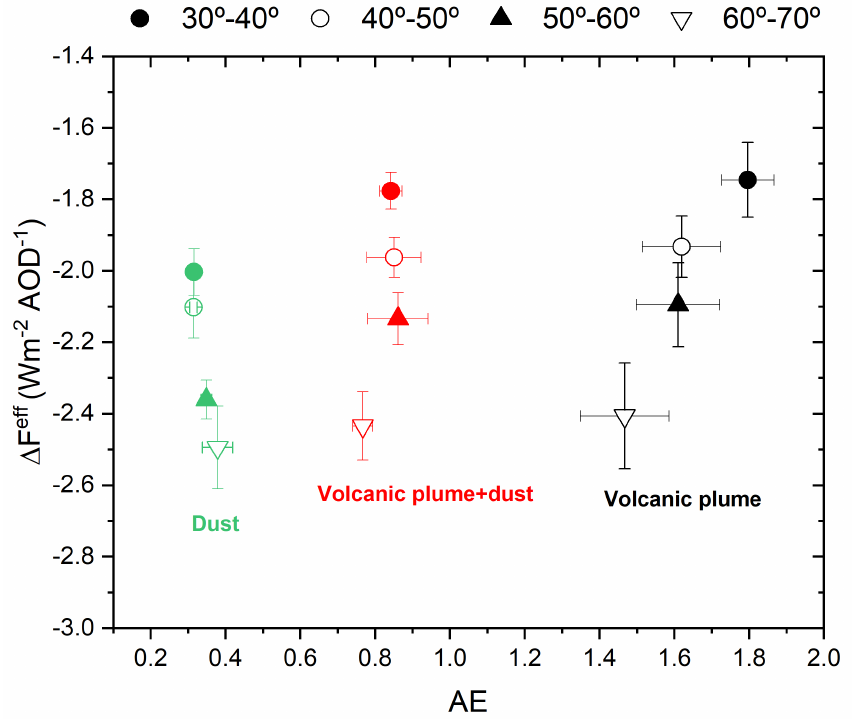
Figure 8. ∆ F Ef f (Wm − 2 nm − 1 AOD − 1 ) at 440 nm versus AE as a function of the SZA ( ◦ ) for the three case studies at the IZO: volcanic plume, dust, and volcanic plume + dust. The dots represent the ∆ F Ef f and AE mean values for SZA intervals of 30–40 ◦ , 40–50 ◦ , 50–60 ◦ , and 60–70 ◦ . Error bars indicate standard